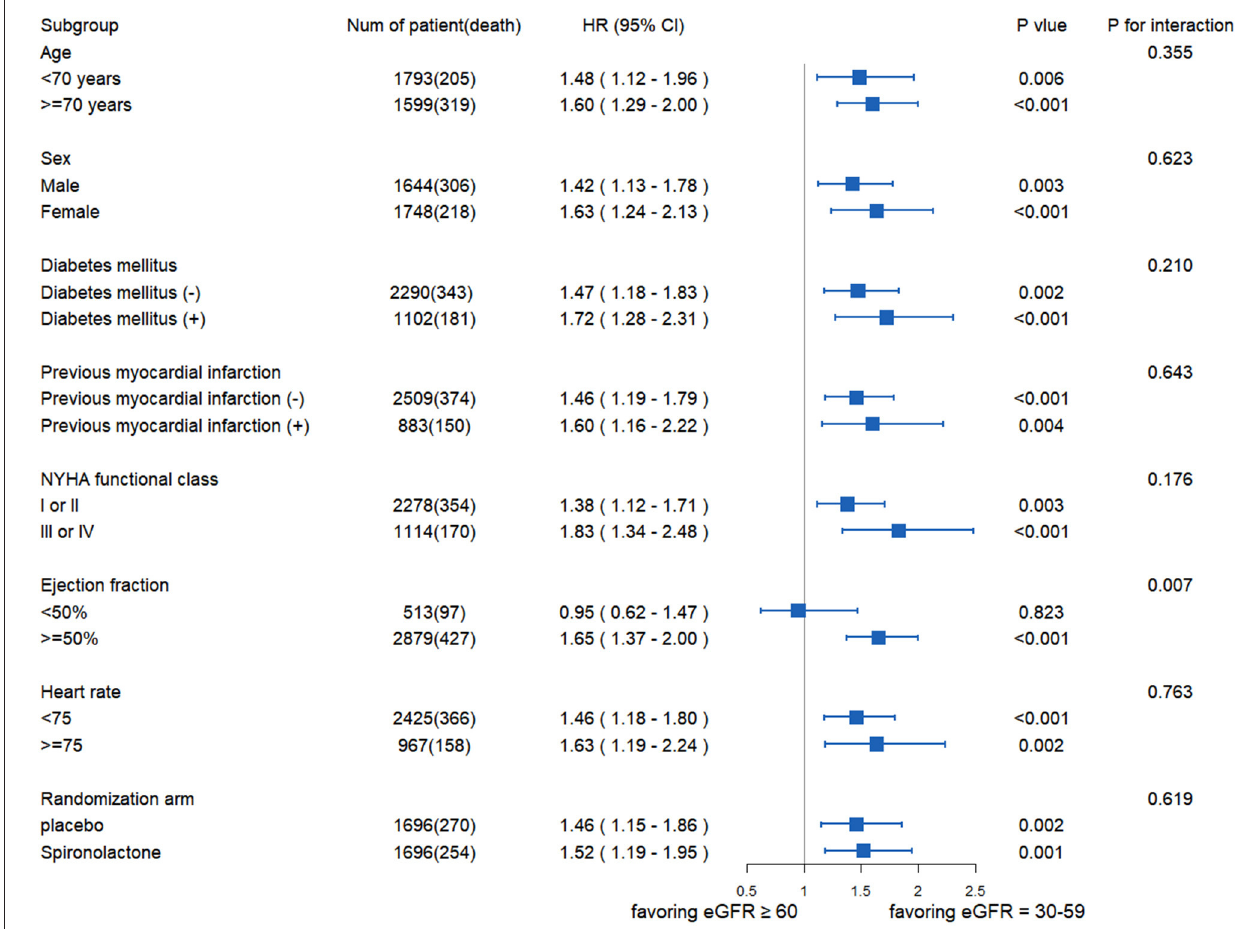
FIGURE 3 | The association between eGFR and all-cause mortality in the different subgroups. NYHA, New York Heart